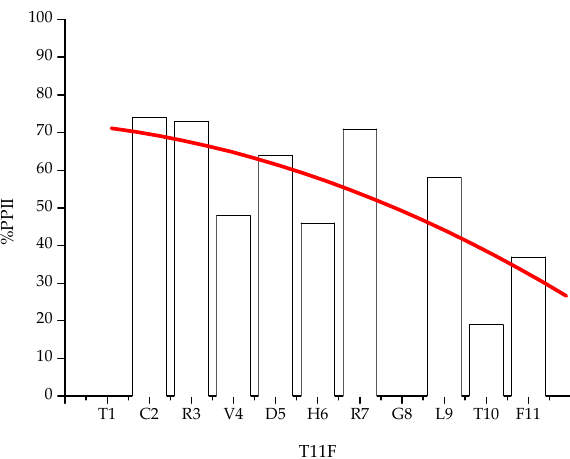
The data indicated that the peptide is characterised by a regular decrease of PPII where Thr and Phe are located (Figure 4).